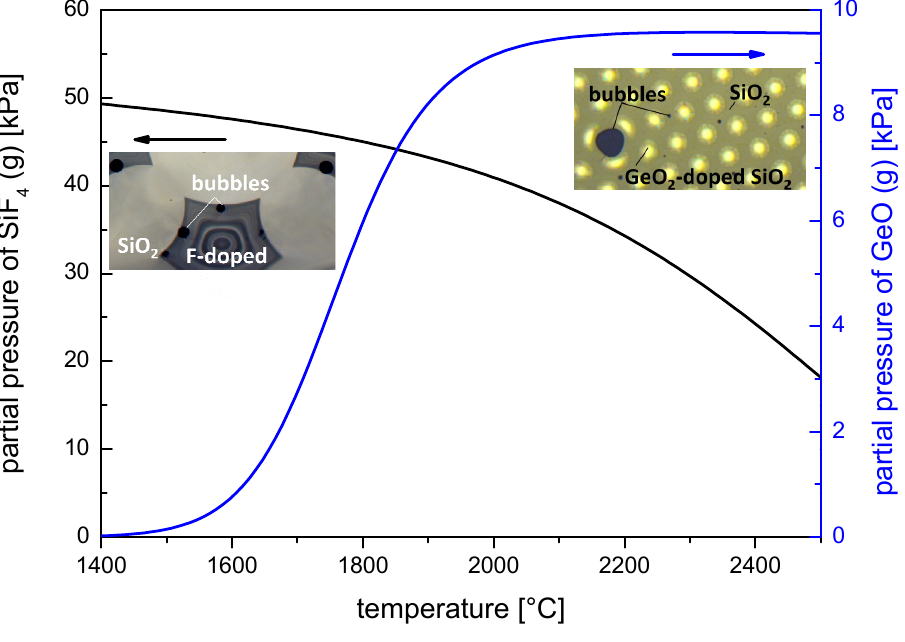
Figure 1. Simulated partial pressure of reaction products according to reactions in Equations (1) and (2) as a function of temperature. Black curve: SiF 4 ; and blue curve: GeO. The inset micrographs exemplarily show the formation of gaseous products during fiber drawing at the contact area between doped und undoped stack elements (black areas inside fiber